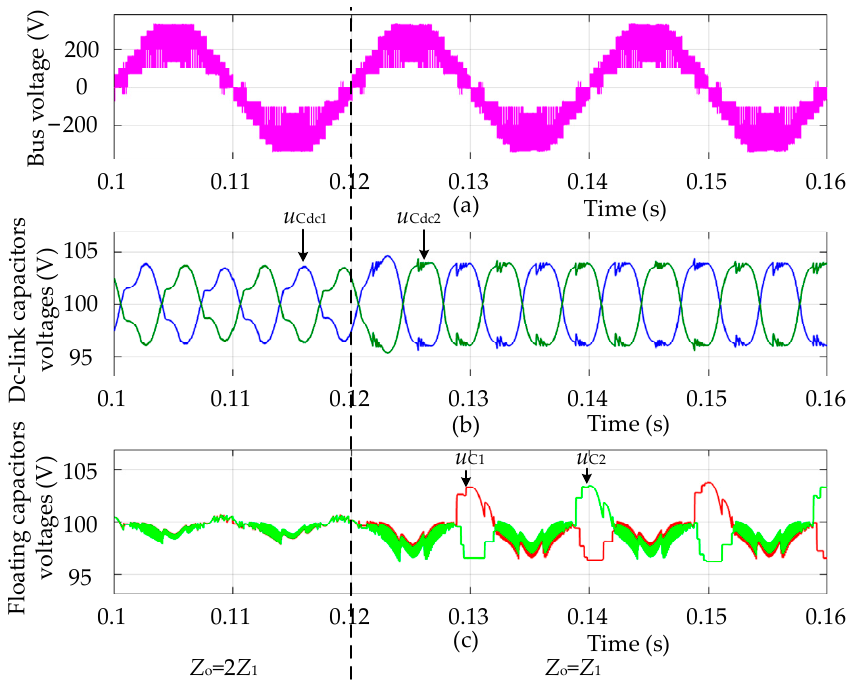
Figure 18. ( a ) The bus voltage, ( b ) DC-link capacitor voltages and ( c ) floating capacitor voltages of the A-phase during a resistive–inductive load transient.